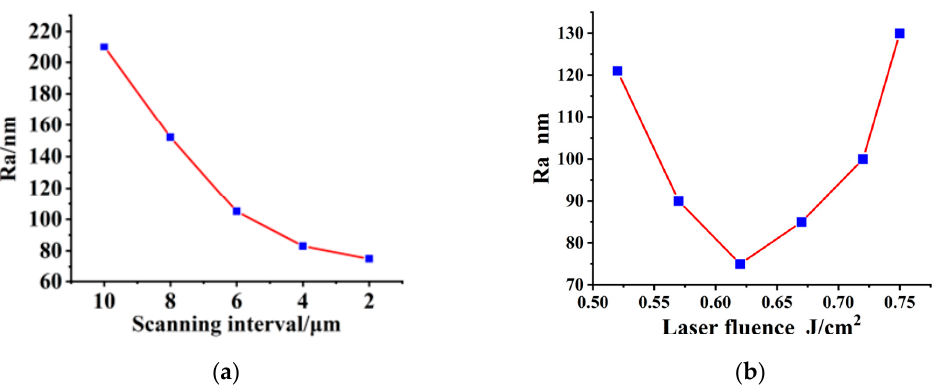
Figure 8. Curve of surface roughness with the change of polishing parameters: ( a ) Scanning interval; ( b ) Laser fluence.